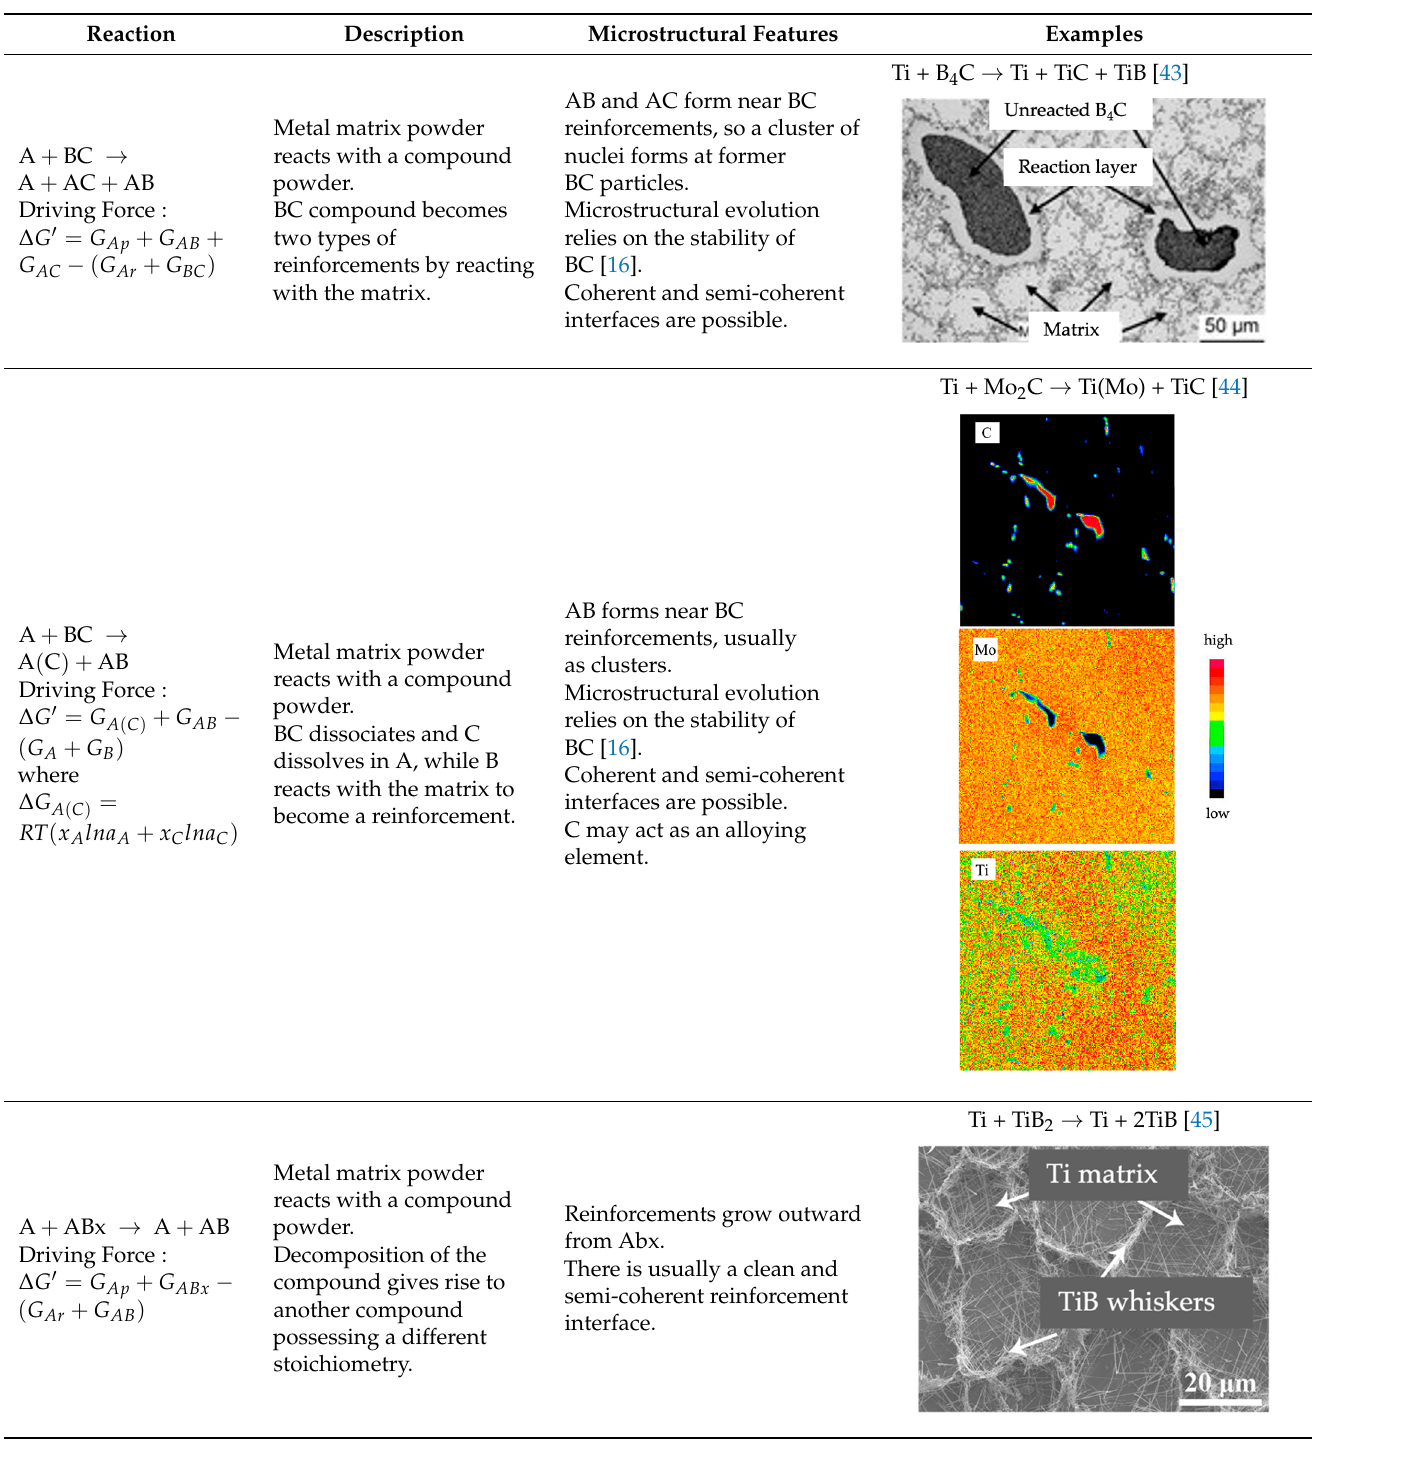
of the reaction, G is the Gibbs free energy of element i. R and P subscripts in the fourth column stand